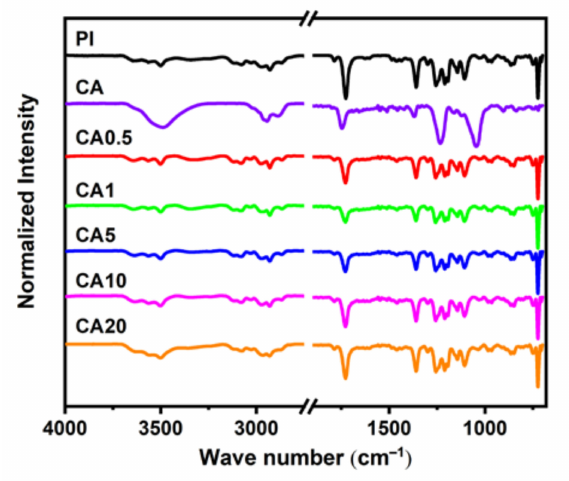
Figure 1. FT-IR spectra of pure CA, pure PI, and composite